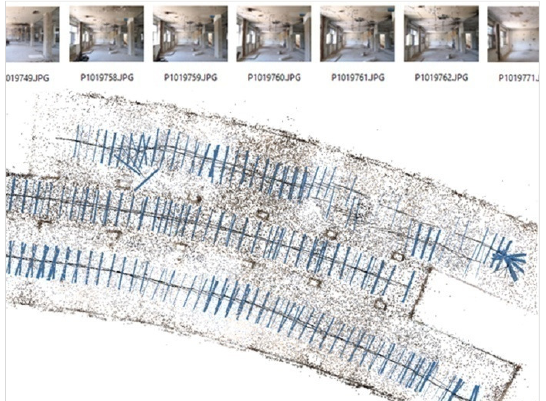
Figure 2: Plan view of a portion of the point cloud of a standard level, displayed in Photoscan. Photo plans are showed in